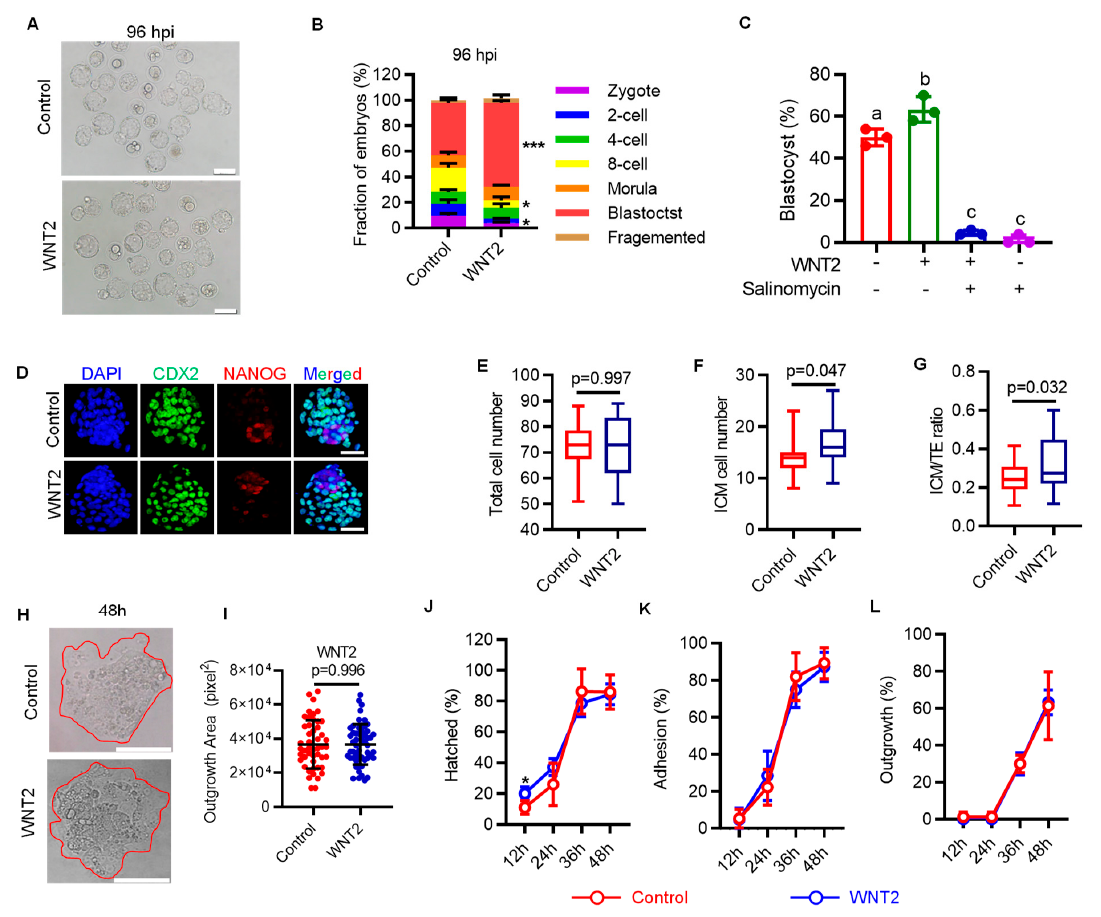
Figure 4. Exogenous WNT2 increases the implantation potentials of embryo. ( A ) Representative images of IVF blastocysts treated with or without WNT2 from zygote stage. Scale bar = 200 µ